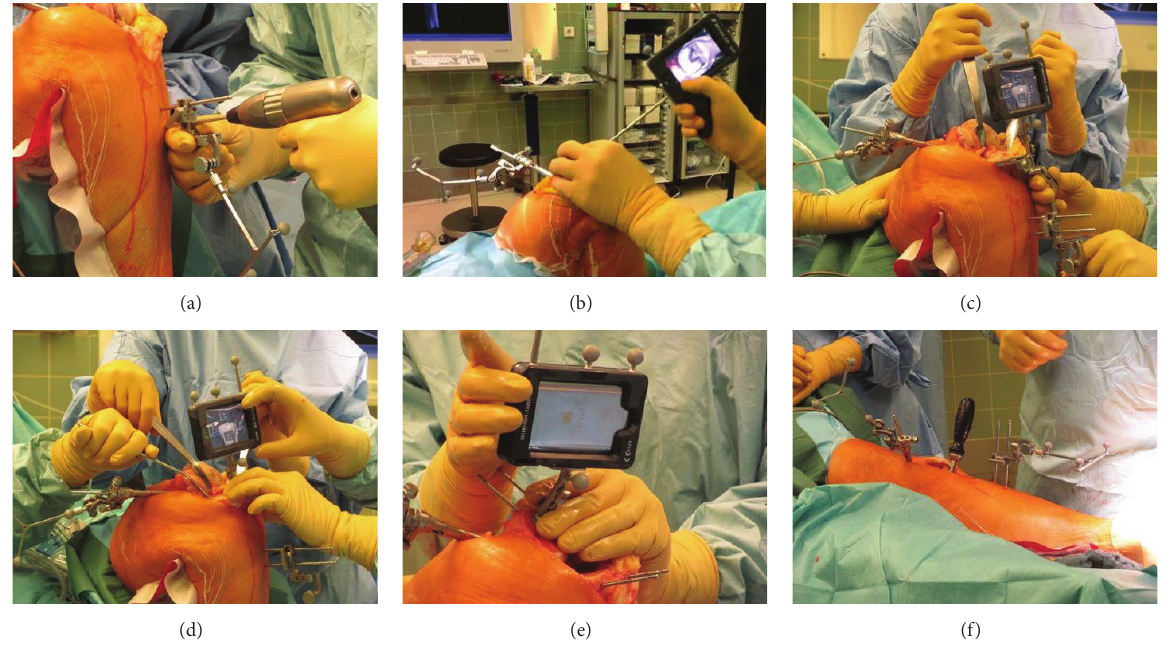
Figure 2: (a) Attachment of reference arrays. (b) Digitalisation of anatomical landmarks using the pointer, attached to the handheld cradle. (c) The cradle is attached to the cutting block for proximal tibial resection. Data is shown on the iPod screen (varus/valgus, resection level, and slope). (d) Verification of tibial resection. (e) Verification of distal femoral resection. (f) Control of leg alignment and ligament situation.